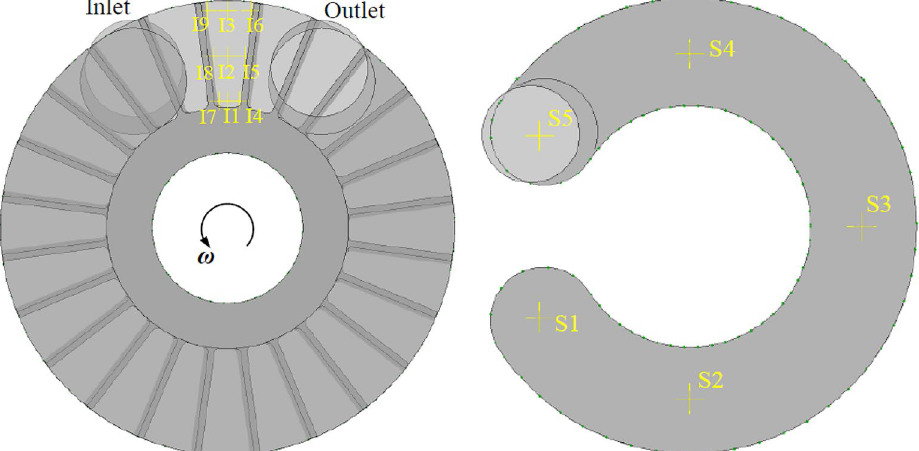
Figure 14 Positions of monitor points in the side channel